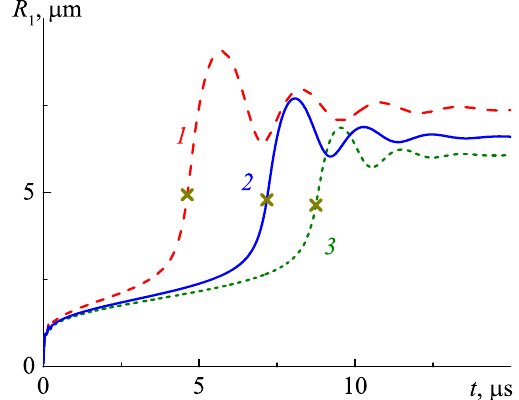
Figure 4. Radius of a vapor bubble for different values of the initial shell thickness: 1— r s 0 = 10 − 7 , 2—1.2 × 10 − 7 , 3—1.3 × 10 − 7 m; G s = 5 × 10 7 Pa and R 20 = 1.85 × 10 − 6 m (the cross shows the moment of complete evaporation of the